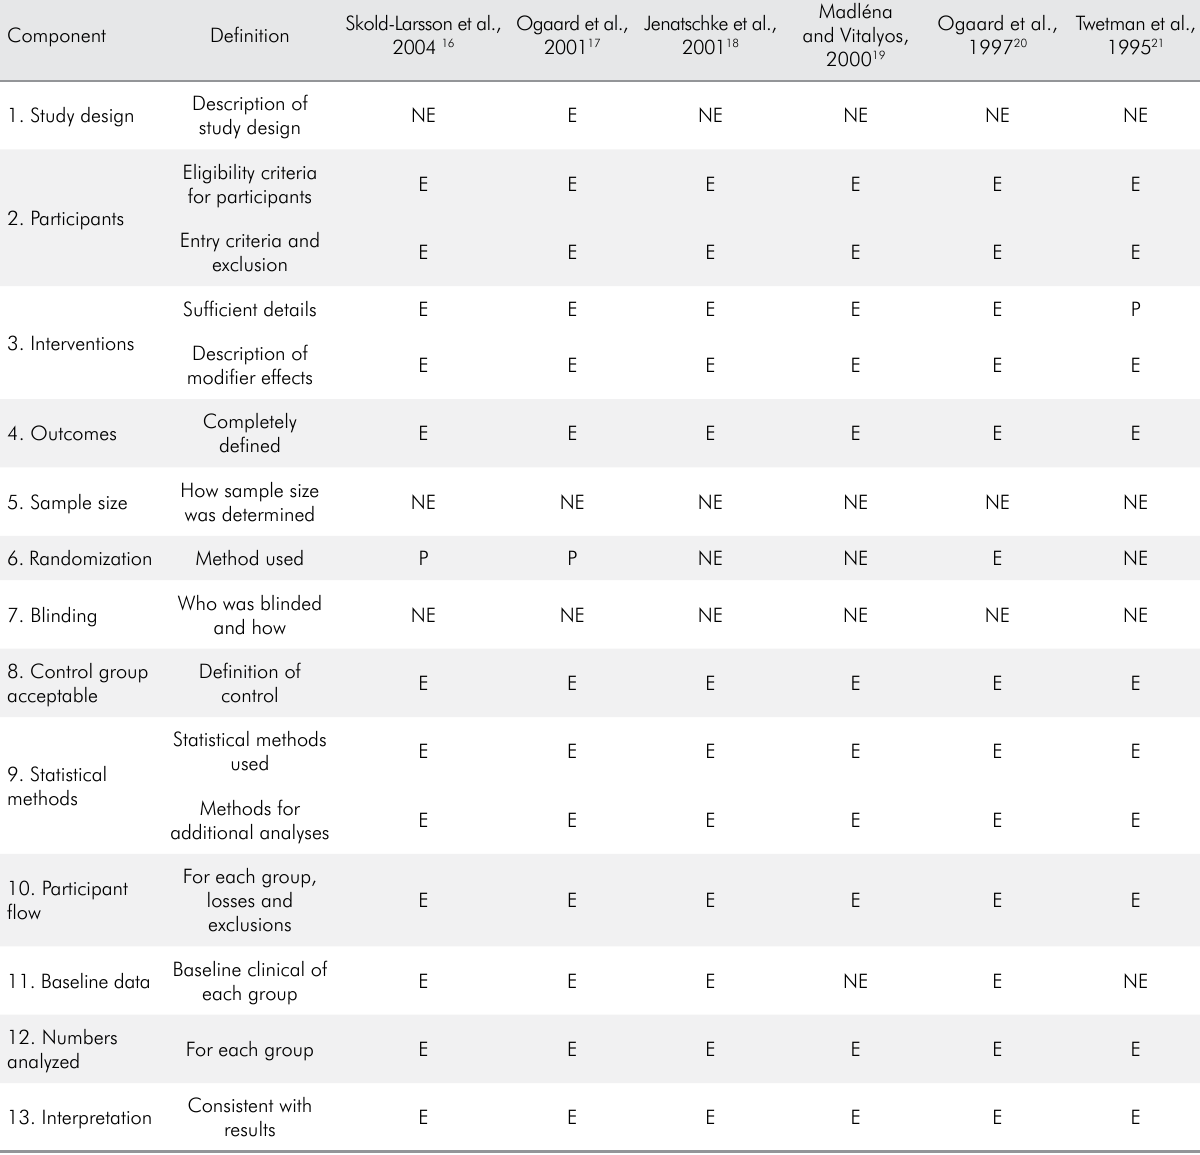
Table 2. Qualitative scoring of the included